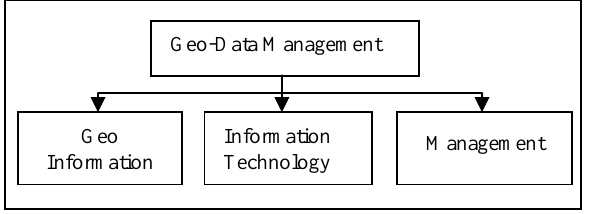
Figure 2. The triad of Geo-data Management, (German DVW Working Group, 2016,